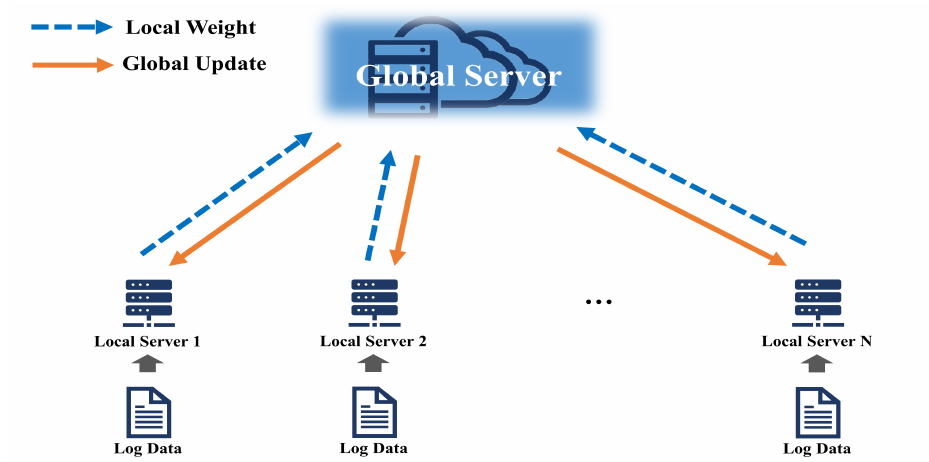
Figure 2. Framework of federated learning